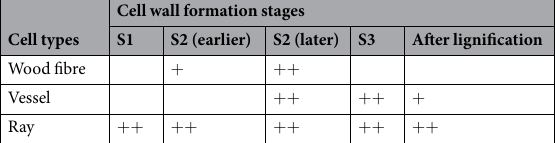
Table 1. Distribution of salicifoline in the xylem region of freeze-fixed stems of M. kobus . Symbols: + , detected a little; ++ , detected